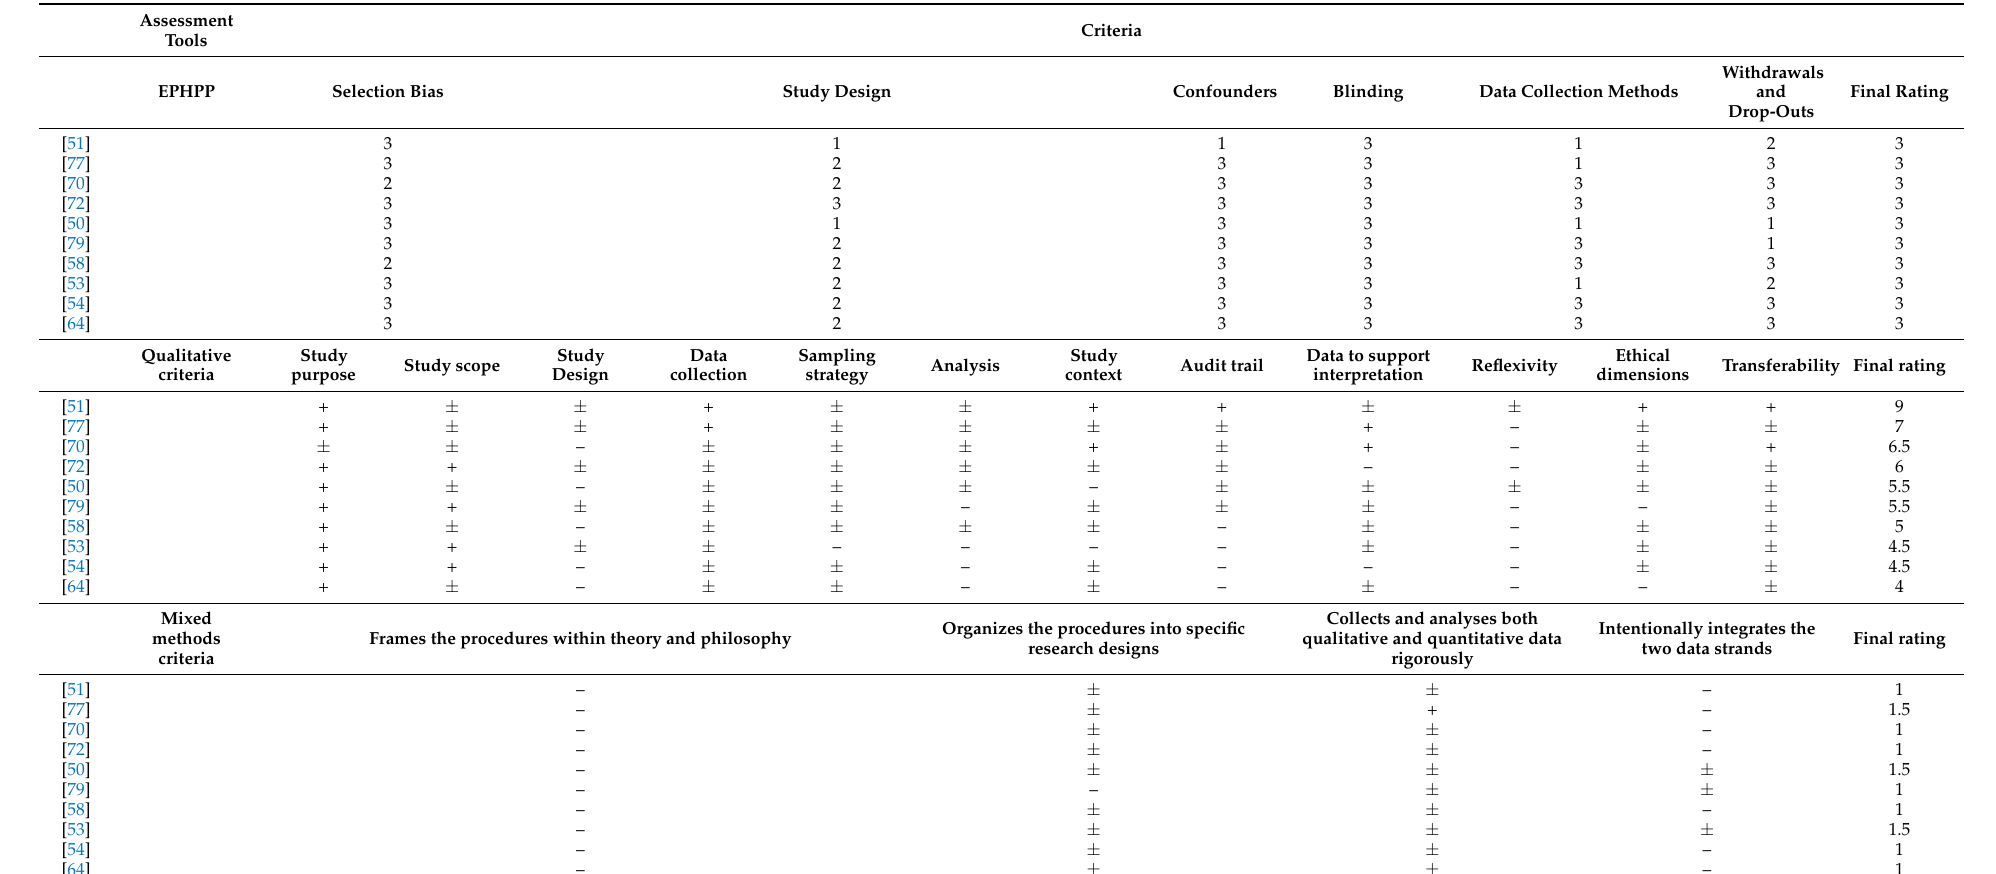
Table 4. Quality appraisal of mixed methods studies (EPHPP, Walsh and Downe criteria, and Creswell and Plano Clark criteria) ( n = 10 )